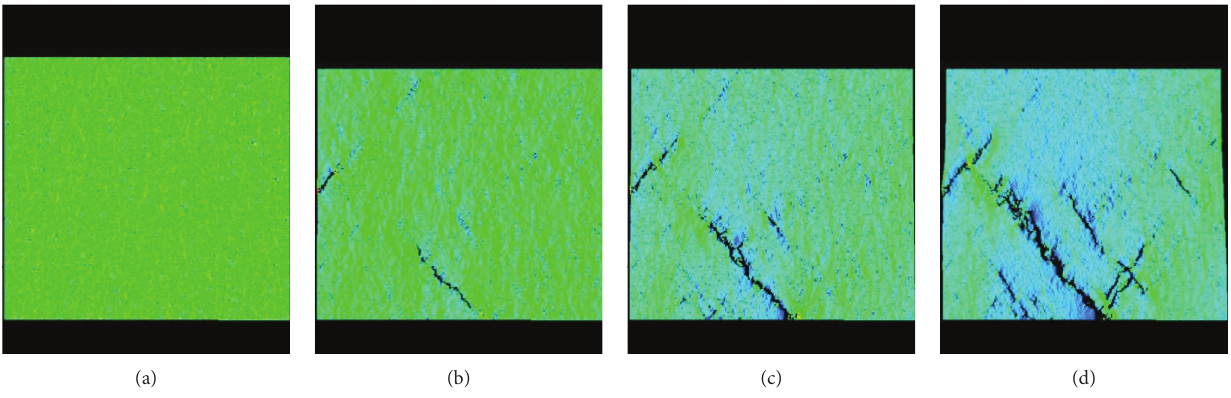
Figure 4: Macrodestruction of rock mass at ratio of height to diameter of 1.